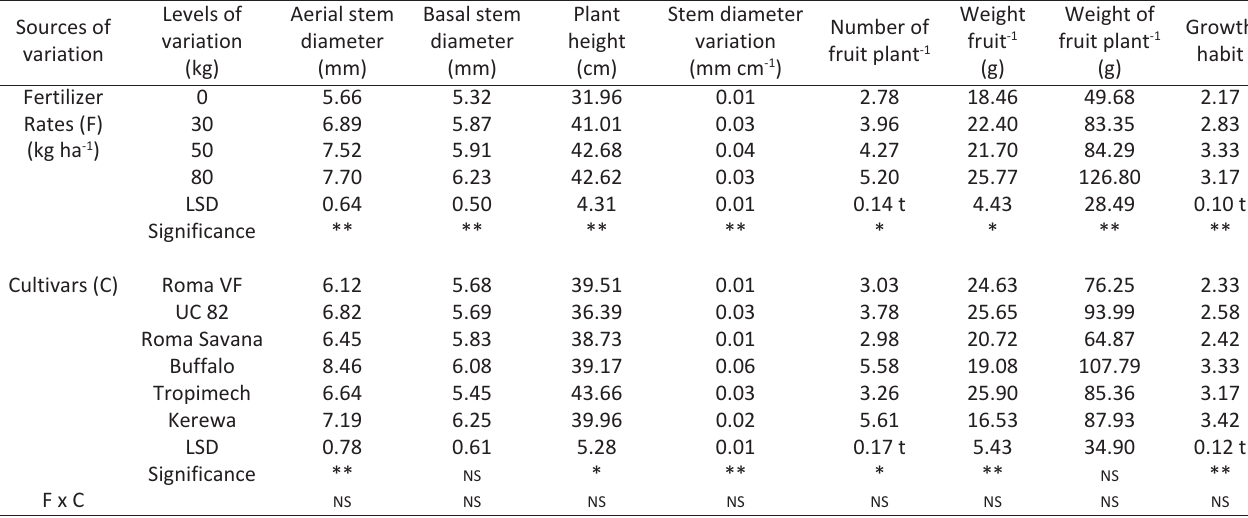
Ilaraa** and * = significant at p≤0.01 and 0.05 probability level respectively; NS = non­significant. Least significant difference ( LSD ) with ‘t’